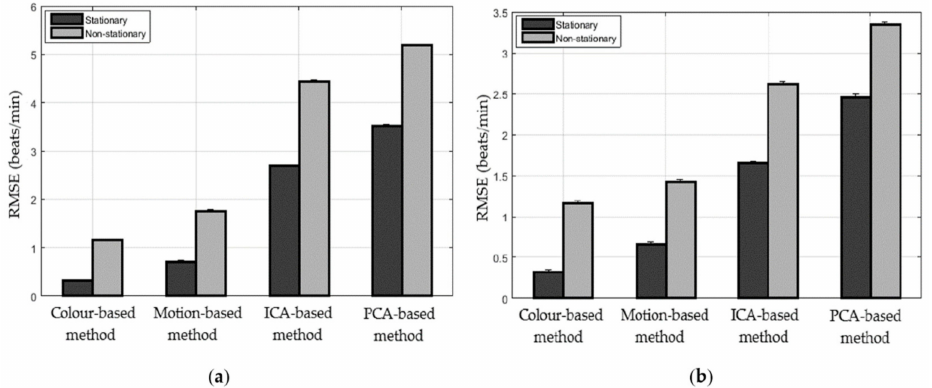
Figure 11. RMSE performance comparison of CEEMDAN and CCA techniques under multiple